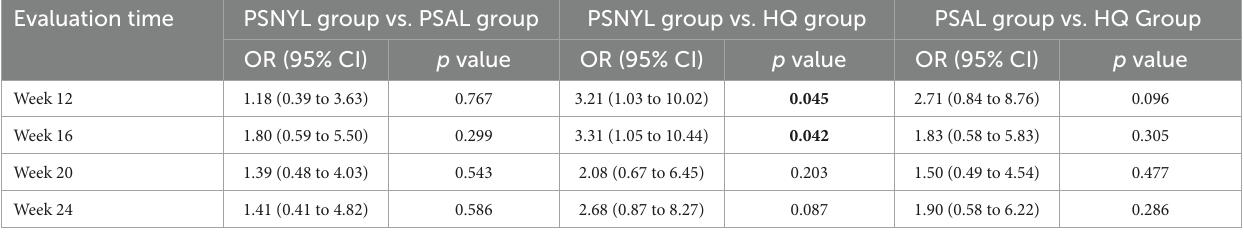
TABLE 4 Outcomes of Between-group Differences in patient assessment scores. Evaluation time PSNYL group vs. PSAL group PSNYL group vs. HQ group PSAL group vs. HQ